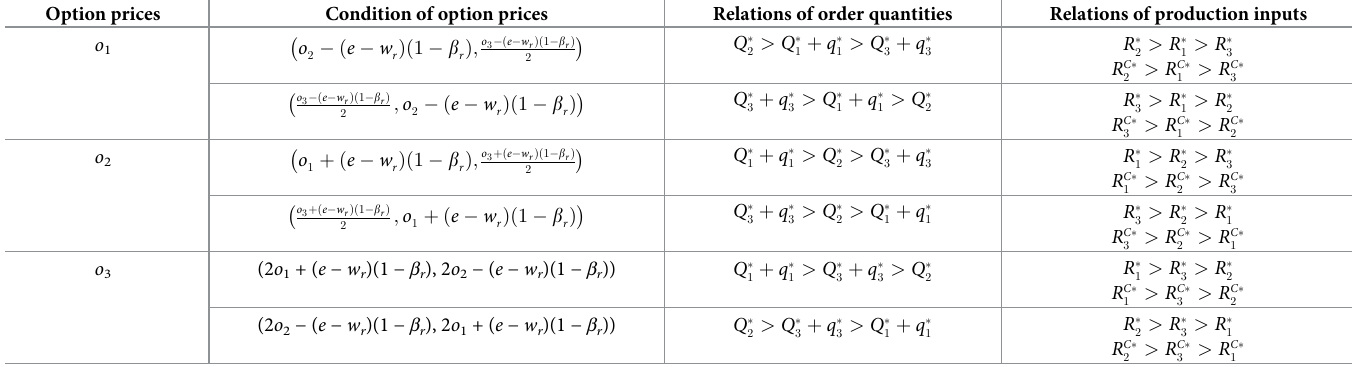
Table 1. Relations of order quantities and production